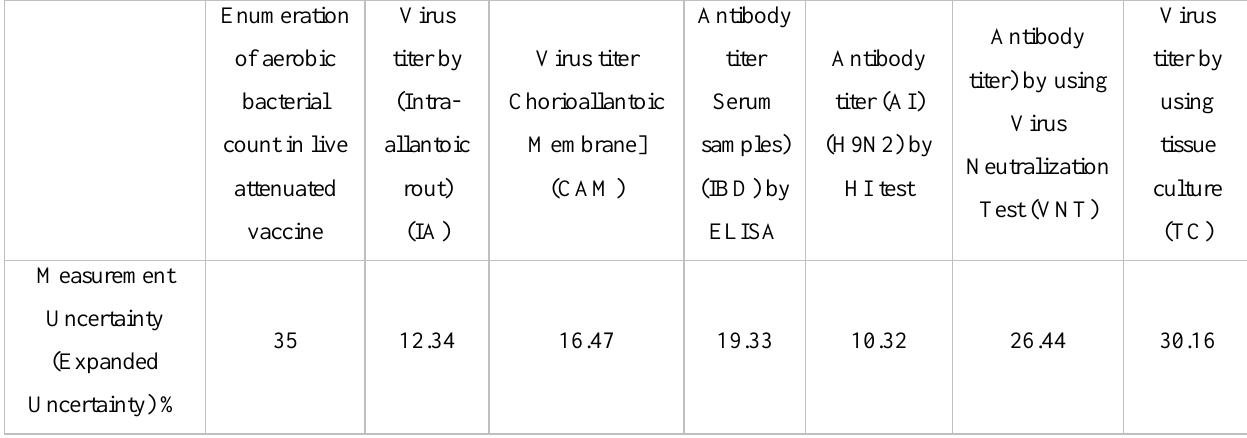
Table 2: Measurement uncertainty for each kind of vaccine was determined (Nordtest TR 569, 2006) and the results are represented in table 2 and figures from 7 to